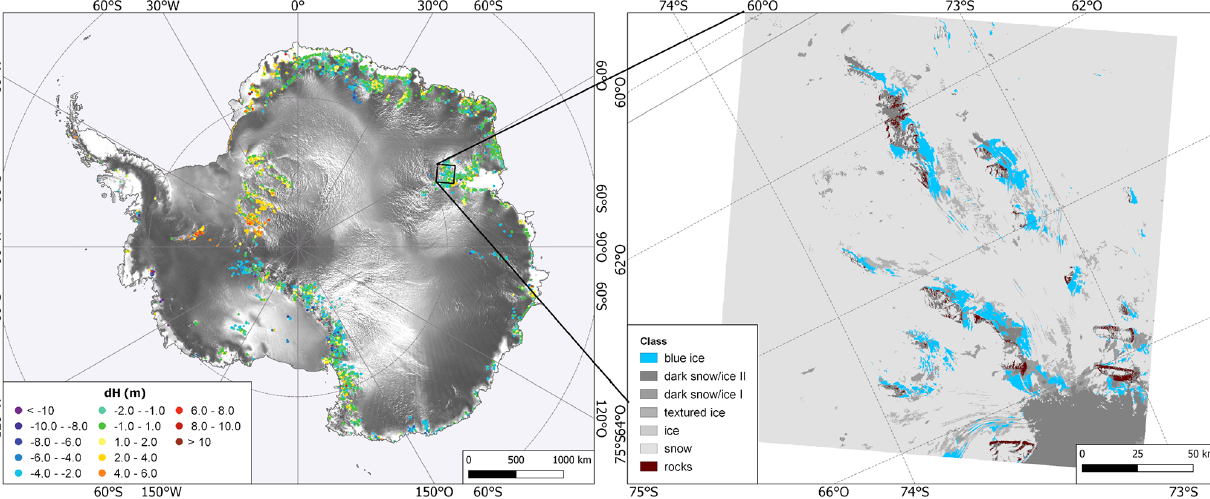
Figure 13. Left panel: distribution of TanDEM-X minus ICESat differences on AntarcticaLC2000 BIAs. Right panel: study area for BIA classification, southern Prince Charles Mountains, Amery Ice